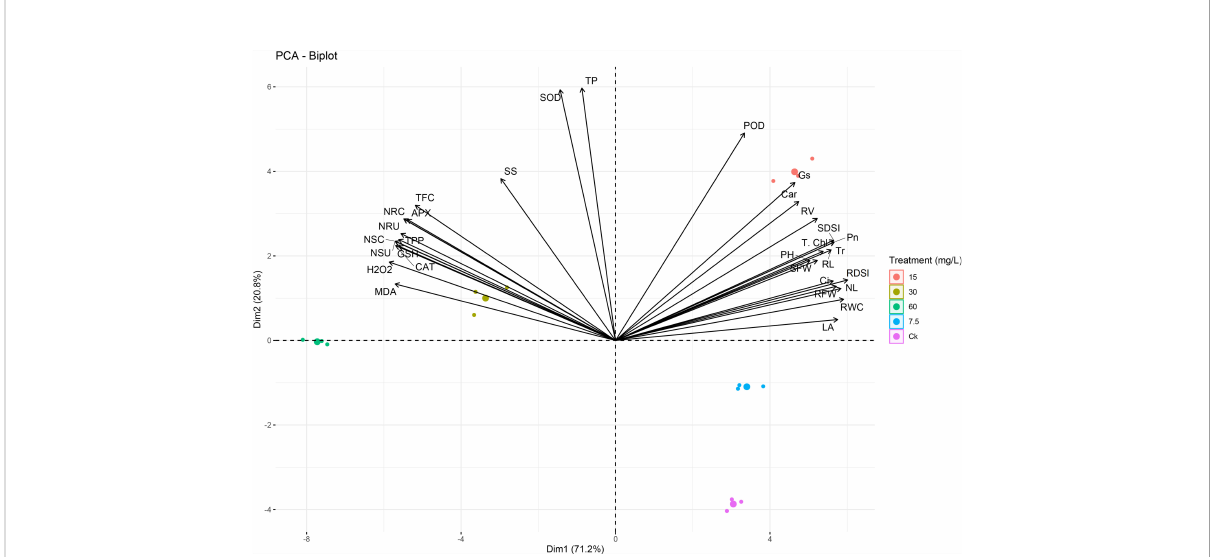
FIGURE 12 Principal component analysis (PCA) between phenotypic, physiological, and biochemical traits under different levels of Ni treatments in sweetpotato plant. MDA, malonaldehyde; H 2 O 2 , hydrogen peroxide; CAT, catalase; GSH, reduced glutathione; NSU, Ni shoot uptake; NSC, Ni shoot concentration; TPP, total polyphenols; NRU, Ni root uptake; NRC, Ni root concentration; APX, ascorbate peroxidase; TFC, total fl avonoids; SS, soluble sugars; SOD, superoxide dismutase; TP, total proteins; POD, peroxidase; Gs, stomatal conductance; Car, carotenoids; RV, root volume; SDSI, shoot dry weight susceptibility index; T. Chl, total chlorophyll; Pn, photosynthetic assimilation; PH, plant height; Tr, transpiration rate; RL, root length; SFW, shoot FW; Ci, Intercellular CO 2 ; NL, number of leaves; RDSI, root dry weight susceptibility index; RFW, root FW; RWC, relative water content; and LA, leaf